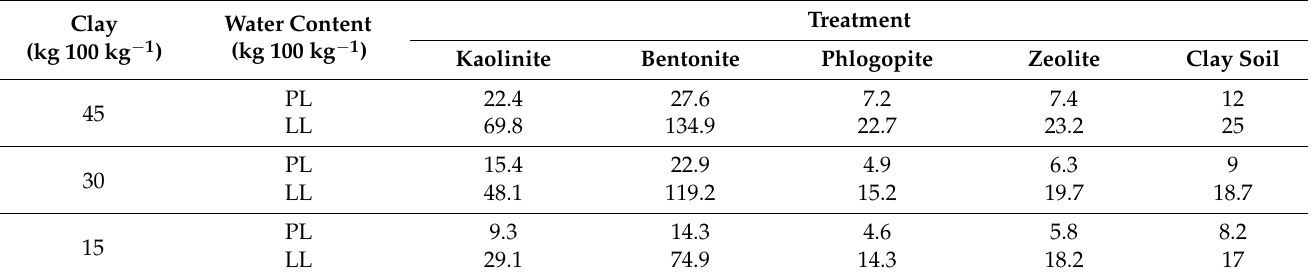
Table 1. Liquid limit (LL) and plastic limit (PL) for the studied clay–sand mixtures and clay soil.